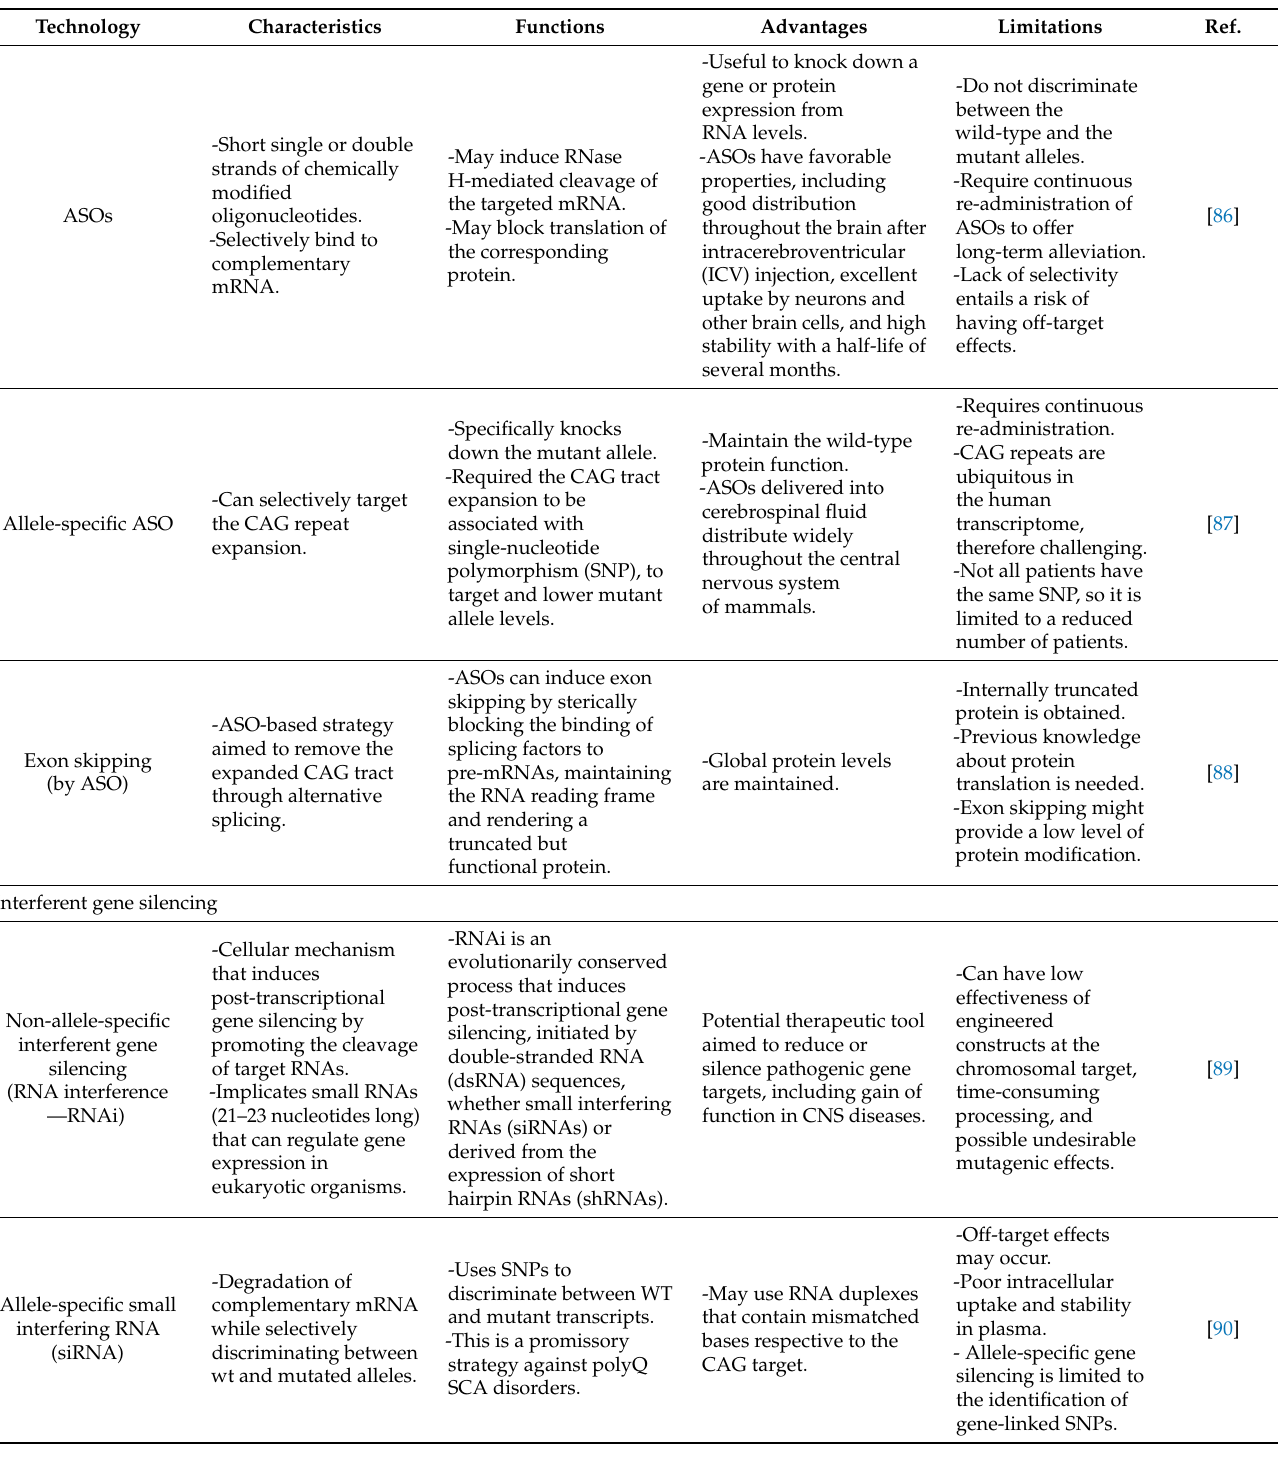
Table 3. Gene therapeutic